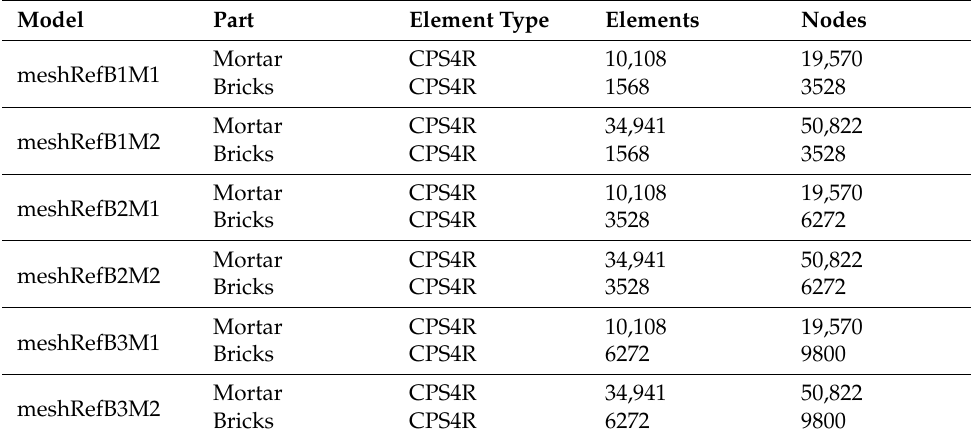
Table 2. Modeling details of the 6 simulation cases used for the mesh refinement